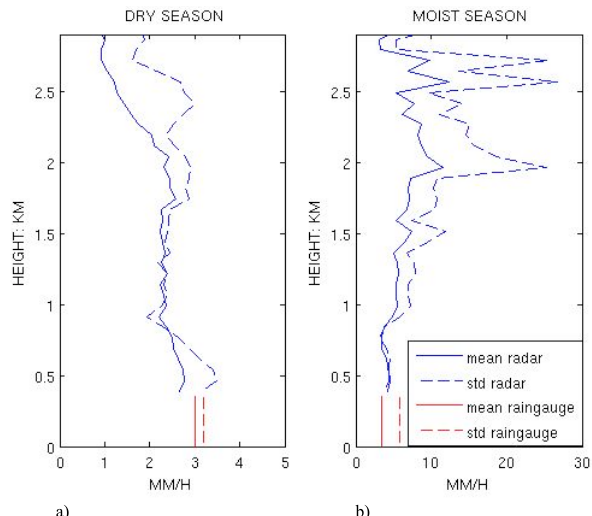
Figure 4: Vertical profile of mean (plain line) and standard deviation (dashed line) of the rain 673 Fig. 4. Vertical profile of the mean (plain line) and standard devia- rate as derived from UHF radar measurements during (a) the dry season and (b) the warm 674 tion (dashed line) of the rain rate as derived from UHF radar mea- season. Red lines show corresponding rain-gauge estimates at sea-level. 675 surements during (a) the dry season and (b) the warm season. Red 676 lines show corresponding rain-gauge estimates at